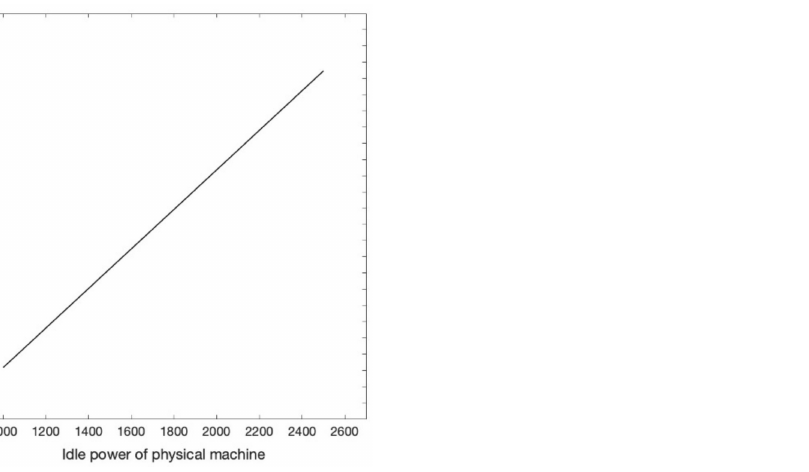
Figure 7. The effect of the idle power of the physical machine on energy consumption cost.